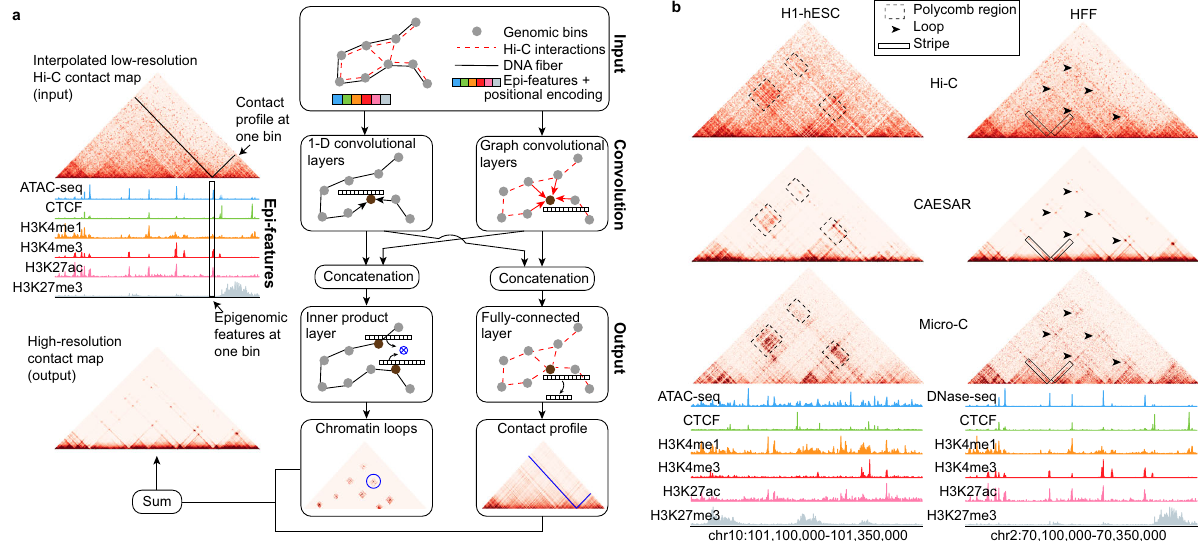
Fig. 1 Overview of the model. a Model architecture. The model inputs are a Hi-C contact map and a number of epigenomic features including histone modi fi cations, chromatin accessibility, and protein binding pro fi les. The lower-resolution Hi-C contact map is fi rst interpolated into a 200 bp resolution contact map, and then transformed into a graph G in which the nodes represent 200-bp genomic bins and the edges represent the interpolated contacts between the nodes. Positional encoding is unrelated to Hi-C or epigenomic data and only encodes node order in the genome. The epigenomic features and positional encoding are assigned to the corresponding nodes as node attributes. The inputs are fed into 1D convolutional and graph convolutional layers to generate hidden representations, which extract features from both nearby genomic regions along the 1D DNA sequence and spatially contacting regions speci fi ed by G . The output layers take input the hidden representations and predict the contact pro fi le at each 200-bp bin as well as the chromatin contacts between bins. b In an example region, the polycomb interactions are accurately predicted by CAESAR. In another example region, loops and stripes undetected by Hi-C are accurately predicted by